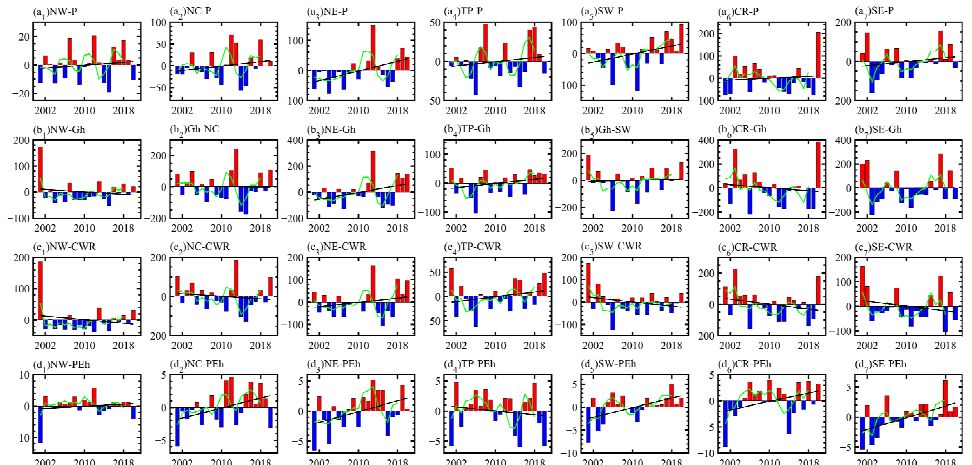
Figure 10. Summer annual time series variations of anomalies of ( a 1 – a 7 ) P (unit: mm·yr − 1 ), ( b 1 – b 7 ) Gh (unit: mm·yr − 1 ), ( c 1 – c 7 ) CWR (unit: mm·yr − 1 ), and ( d 1 – d 7 ) PEh (unit: %·yr − 1 ) in the seven sub-regions of China during the summers of 2001–2020. The green curve is a 3-year moving average, and the black line is the least squares linear trend.